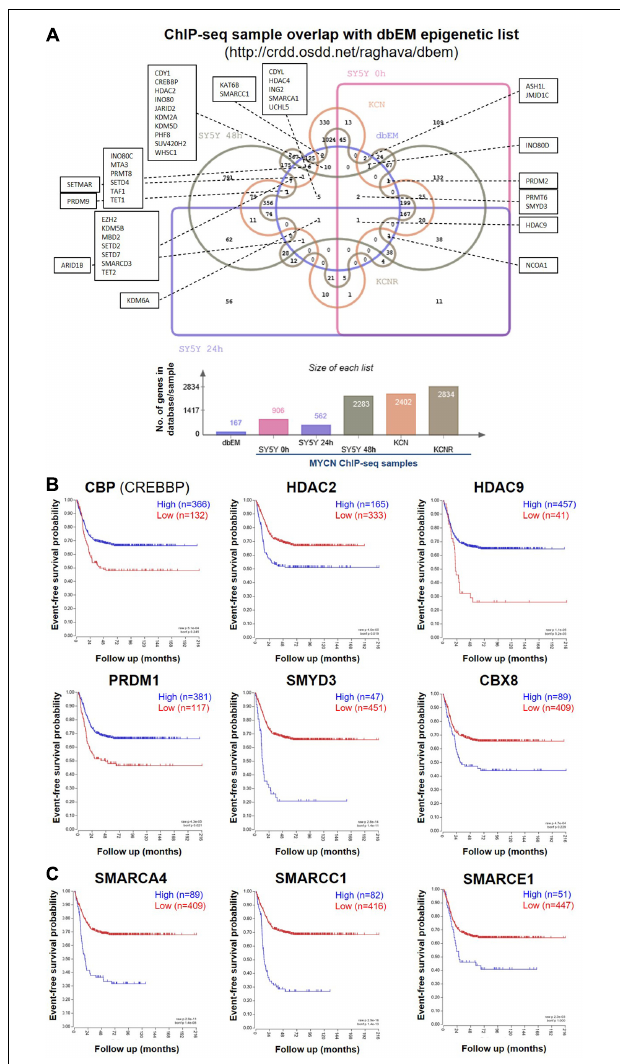
FIGURE 1 | MYCN ChIP-seq epigenetic hits and their survival curves. (A) Venn diagram showing the overlap of genes called as genomic MYCN targets (ChIP-seq) in SY5Y-MYCN (un-induced Dox-, 24 h Dox+ and 48 h Dox+), KCN and KCNR cell lines and known epigenetic genes (Singh Nanda et al., 2016) (dbEM, Database of Epigenetic Modifiers, http://crdd.osdd.net/raghava/dbem). The Venn diagram was generated using jvenn (Bardou et al., 2014) (http://jvenn.toulouse.inra.fr/app/index.html). (B) Kaplan-Meier survival curves showing the predictive strength of the expression levels of the CBP, HDAC2, HDAC9, PRDM1, SMYD3, and CBX8 mRNAs in neuroblastoma tumours on patient outcome. (C) Kaplan-Meier survival curves showing the predictive strength of the expression levels of SMARC genes in neuroblastoma tumours on patient outcome. The SMARCs shown were predicted to be upstream regulators of MYCN’s genomic targets (ChIP-seq). SMARCC1 was also a direct MYCN target (ChIP-seq). All survival curves were generated using the SEQC (Zhang et al., 2015) 498 neuroblastoma tumour dataset in the R2: Genomics Analysis and Visualization Platform (http://r2.amc.nl).